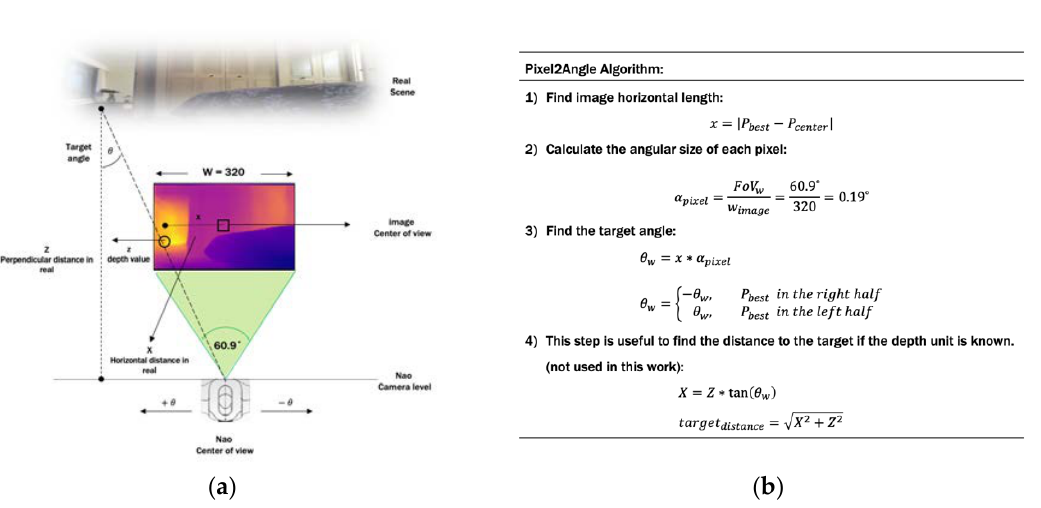
Figure 7. Pixel2angle module for Nao robot. ( a ) Pixel2Angle module illustration; ( b ) Pixel2Angle module calculation.